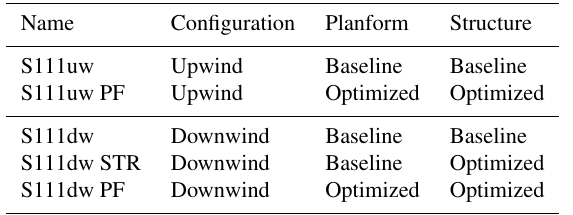
Table 1. Turbine configurations regarded in design and cost estima- tion.